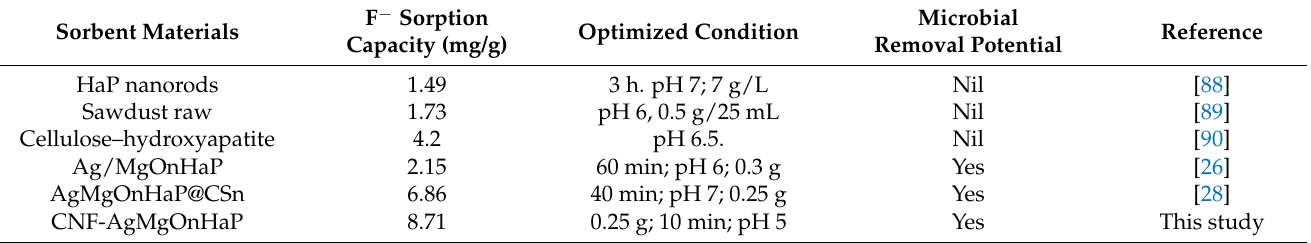
Table 6. Comparative analysis of CNF-AgMgOnHaP to other